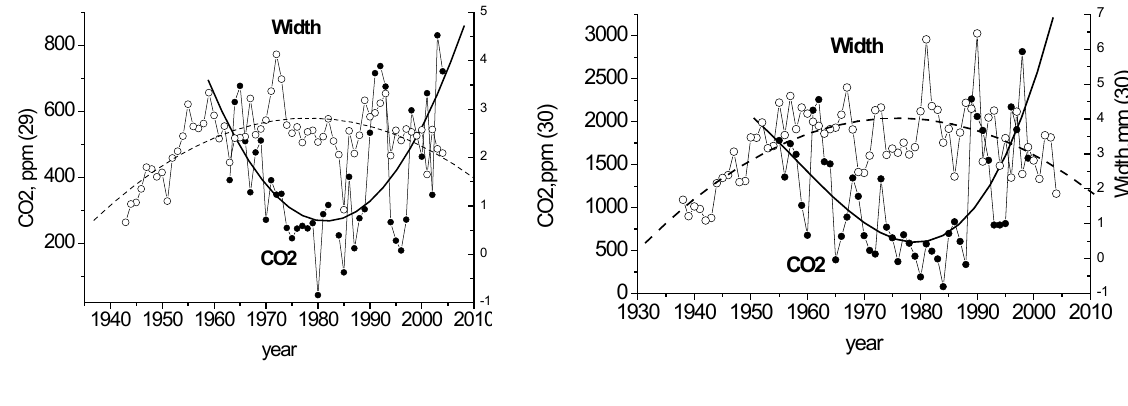
Figure 3. Annual trends of the tree-ring CO (No. 29, 30).